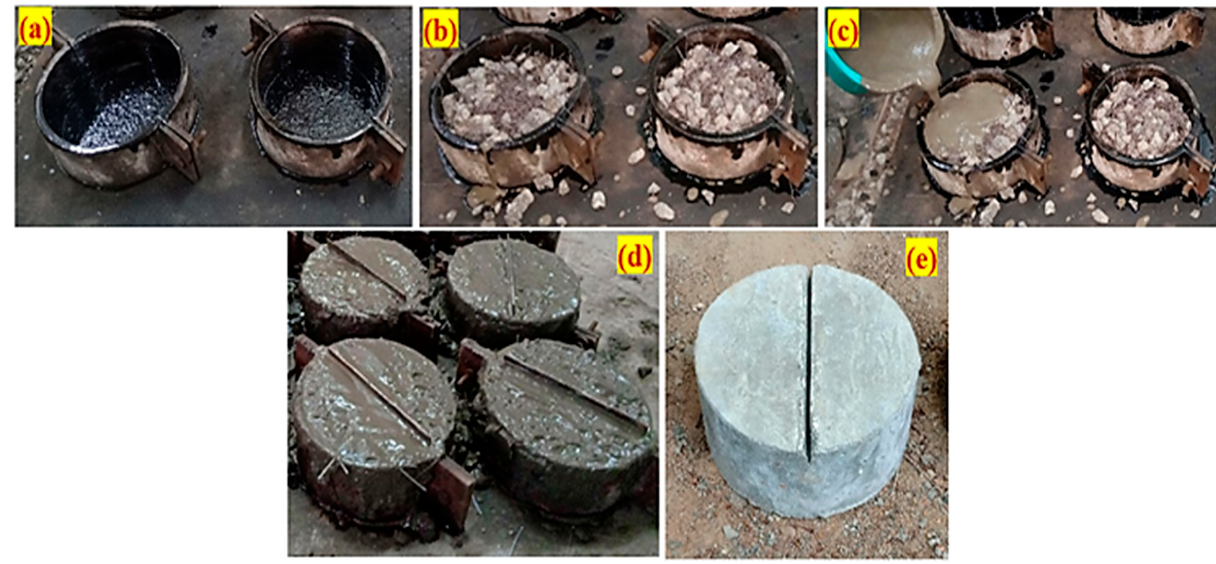
Figure 4. Casting procedure of FLTSFC.